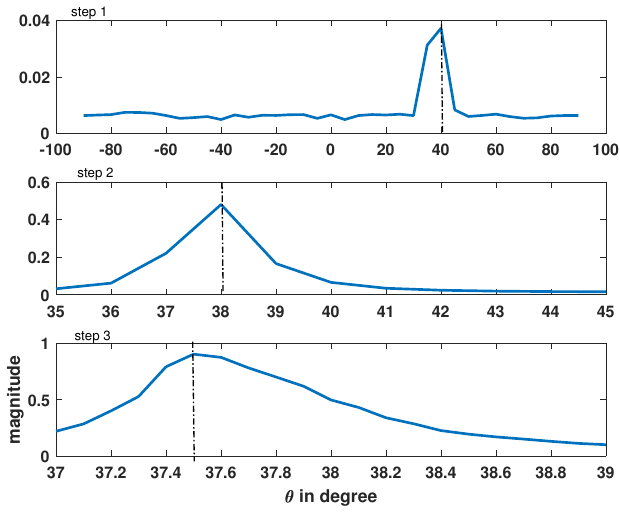
Figure 4. Three-step MEDCD-RLS-DL DoA estimator: θ true = 37.5 ◦ .